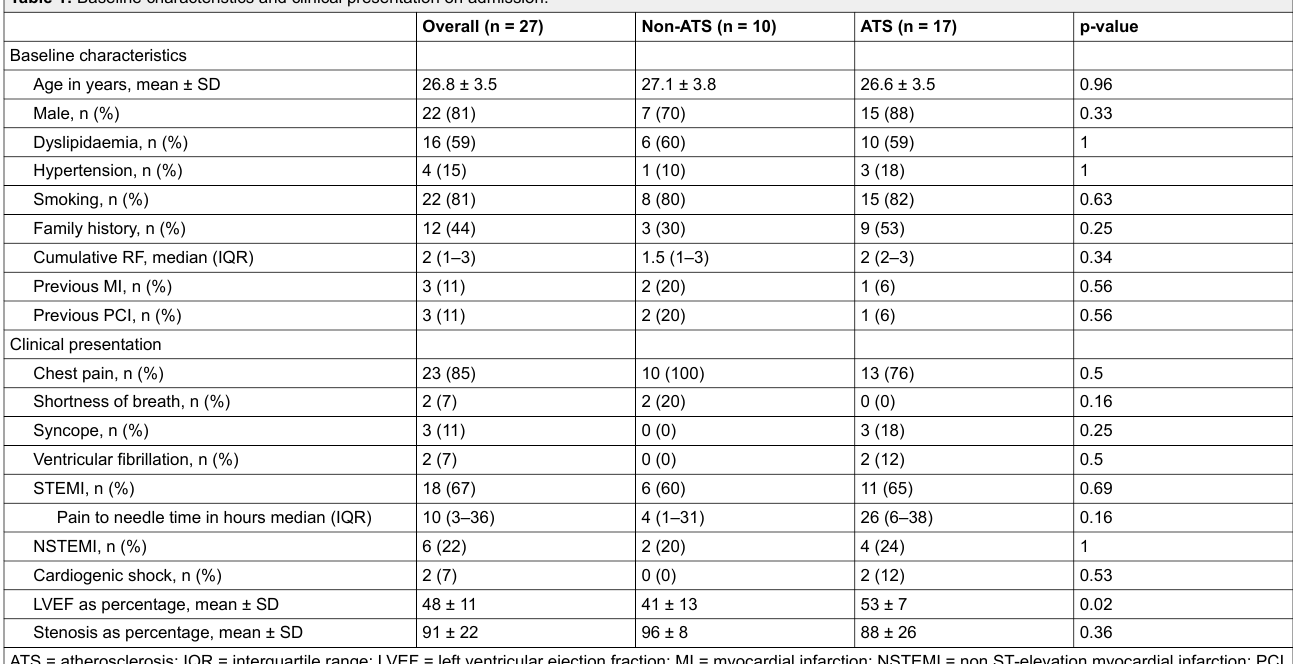
Table 1: Baseline characteristics and clinical presentation on admission.